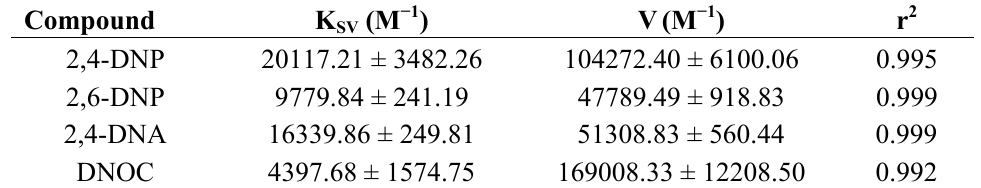
Table 2. Fluorescence extinction characteristics obtained using nonlinear regression Stern-Volmer Equation (2).